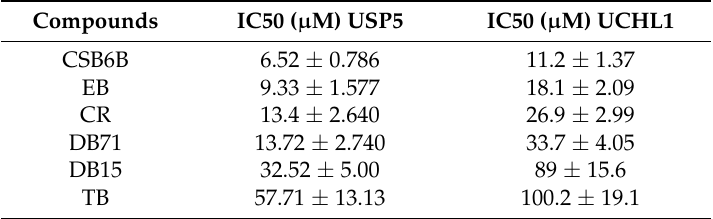
Table 2. Half maximal inhibitory concentration (IC 50 ) of different compounds toward DUB activity of USP5 and